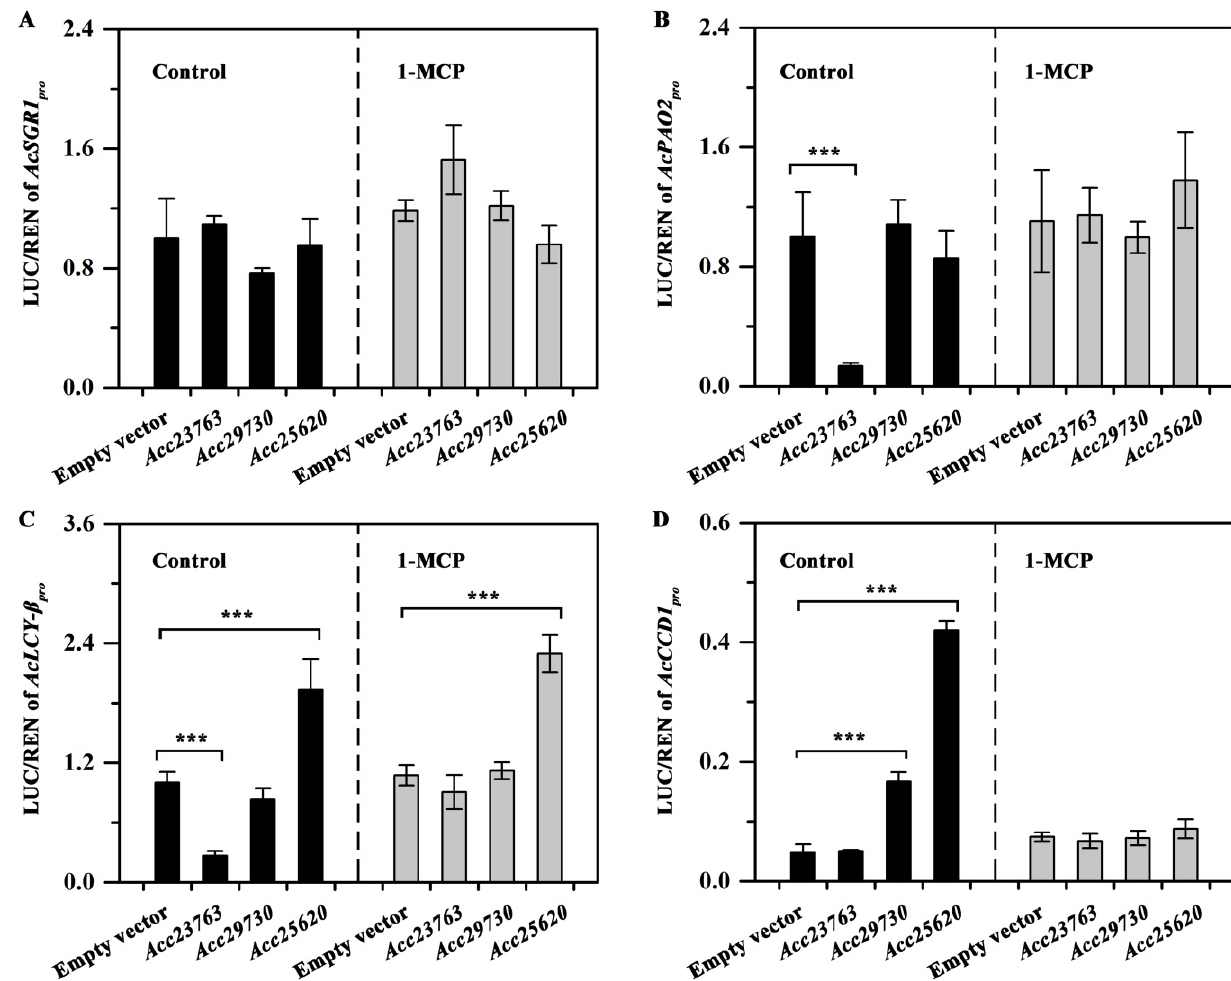
Figure 7. The activation of AcSGR1 ( A ), AcPAO2 ( B ), AcLCY- β ( C ) and AcCCD1 ( D ) promoters by Acc25620 , Acc29730 , and Acc23763 after 1-MCP treatment. Error bars show the standard errors of the means ( n = 3). *** p < 0.001.